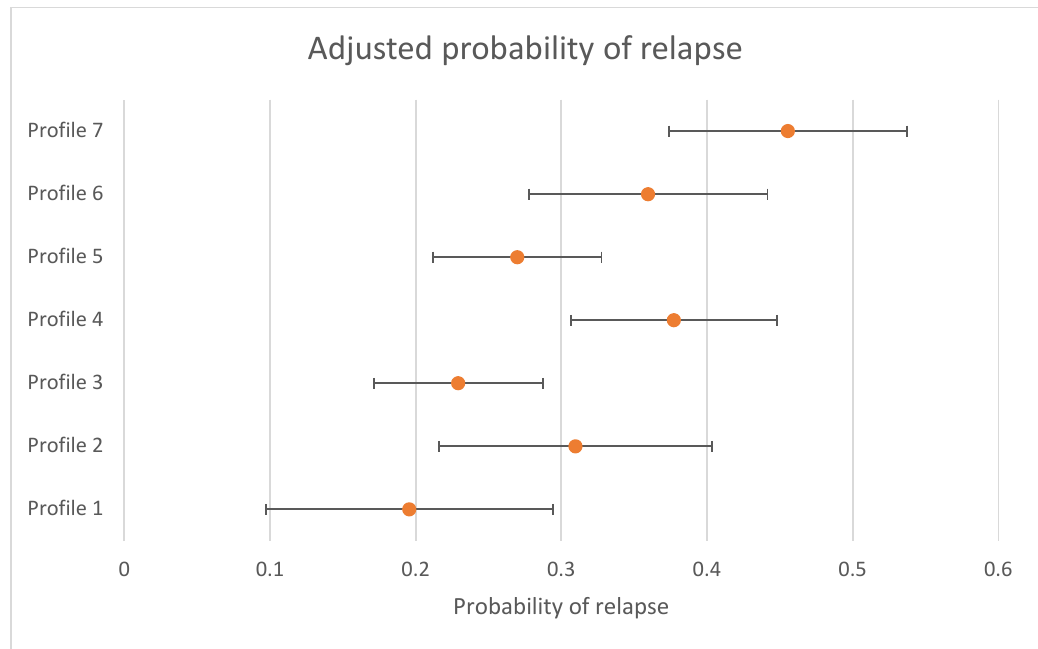
Figure 2. Adjusted probability of relapse by profile (probability and 95% CIs presented).